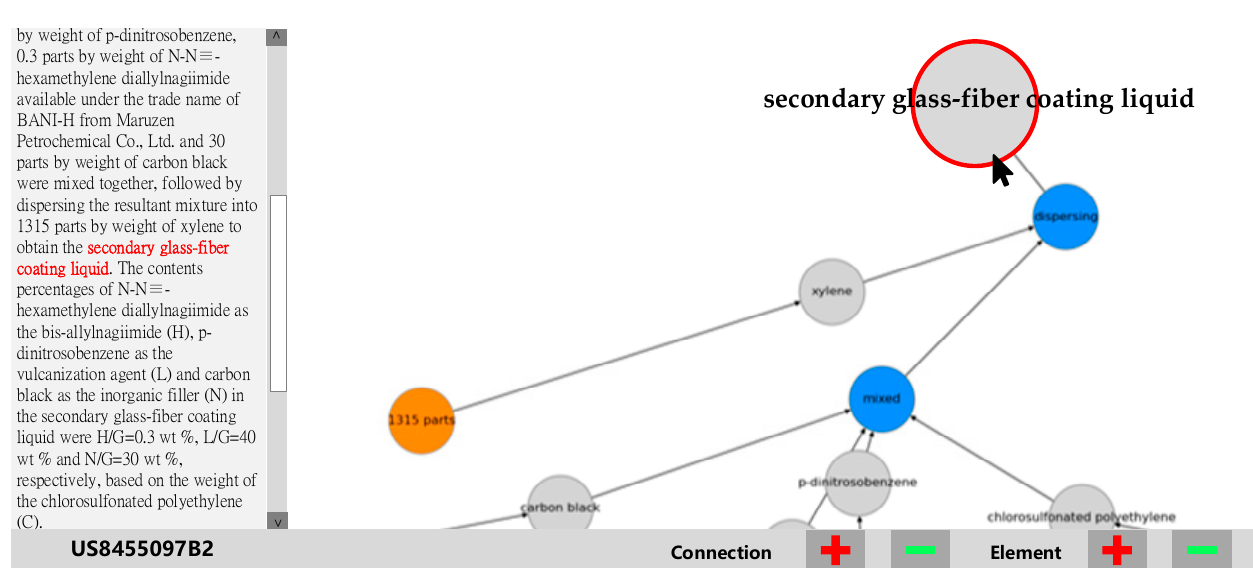
Figure 8. A schematic process graph sample created for chemical utility patent US5132253A.